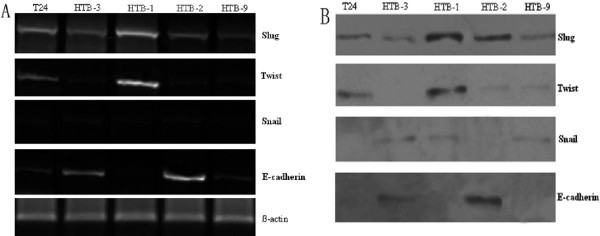
Expression of Snail, Slug and Twist in five bladder cancer cell lines T24, HTB-1, HTB-2, HTB-3 and HTB-9. The analysis of the relative mRNA and protein intensity of Slug, Snail and Twist compared with E-cadherin showed that bladder cancer cells with a high Slug and Twist expression had no or only low E-cadherin expression. In contrast, cells with low Slug and Twist expression had high expression levels of E-cadherin.